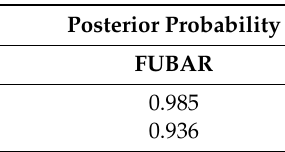
Table 2. Selection analysis of PCV2 ORF2